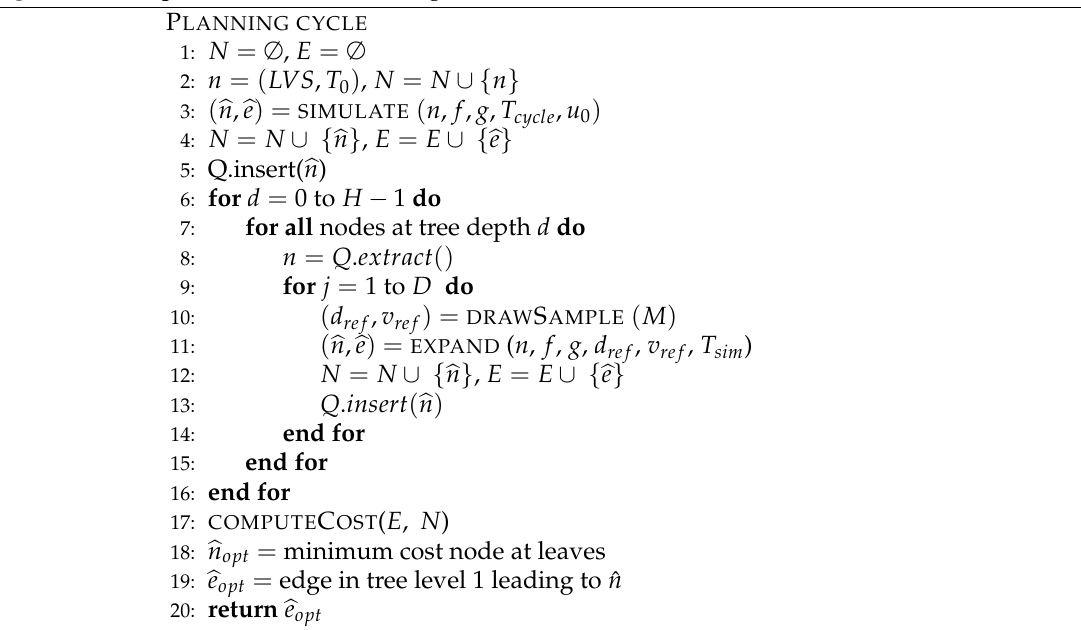
Algorithm 1 Top-level Local Planner